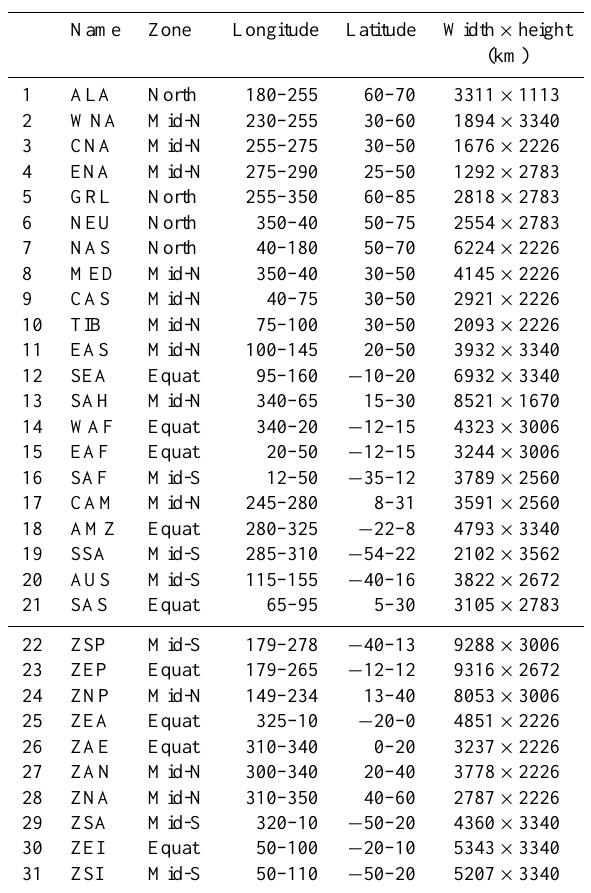
Table 2. Climate region definitions.